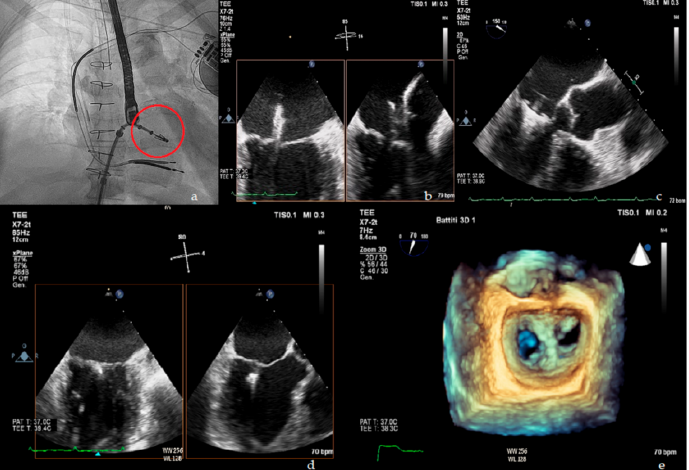
Figure 1. Upper panel : ( a ) fluoroscopic view of MitraClip delivery system (red circle); ( b ) X plane transoesophageal echocardiogram (TOE) view of MitraClip in left atrium; ( c ) TOE left ventricle outflow tract (LVOT) view of MitraClip positioning. Lower panel : ( d ) X plane TOE view of fi- nal clip release; ( e ) 3D en face view showing the double orifice shape of the mitral valve after clip implantation.